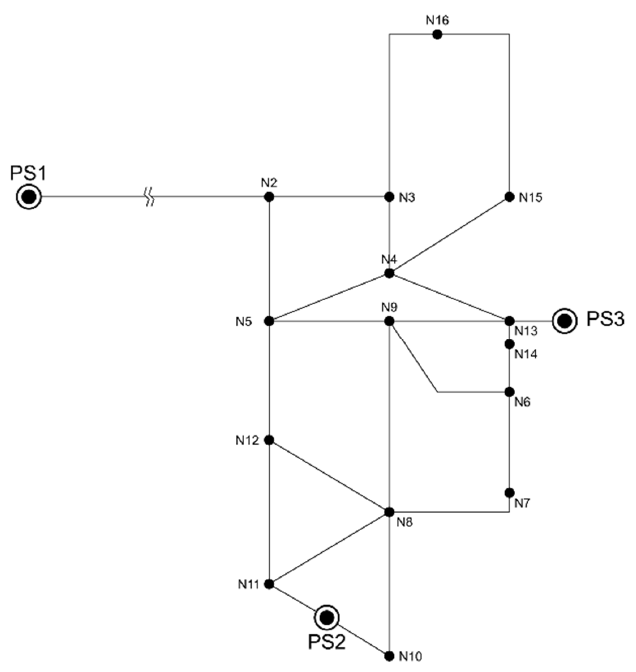
Figure 3. MTF Figure 3. MTF network.